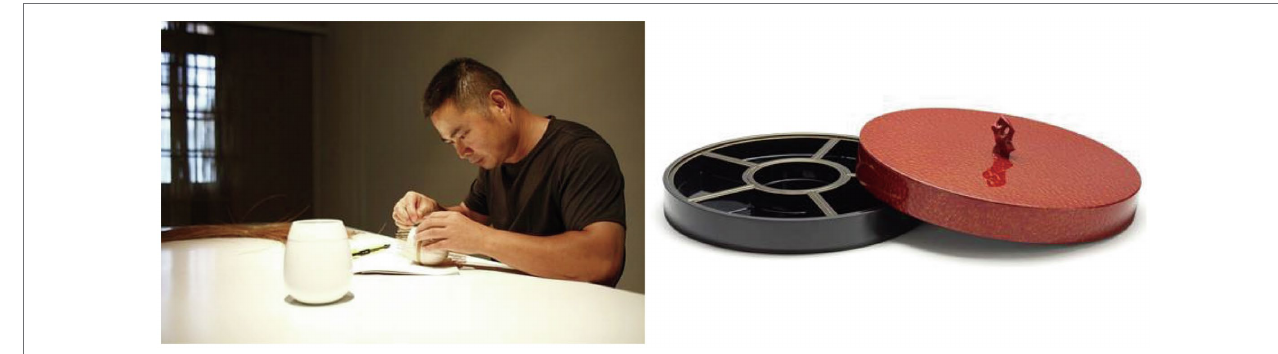
FIGURE 3 | Shiatzy Chen’s Su embroidery and Ne Tier’s kesi craftsmanship in Huafu. The two photos displayed here were taken and kindly provided by Shangxia’s retail manager Mrs.